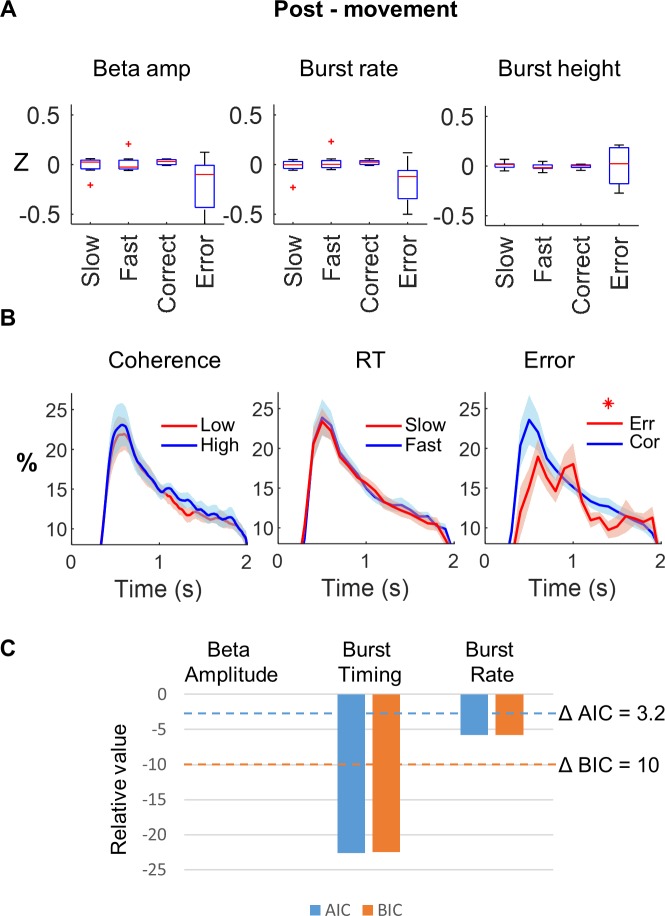
Relationship between beta and errors post-movement.(A) Post-movement beta amplitude, burst rate, and burst height, z-score normalised within subject and split according to trials, with slow versus fast response times and correct versus incorrect trials. Note the decrease in beta amplitude and burst rate on error trials, although this was not significant following FDR correction. (B) Post-movement, there was no significant difference between beta bursts on low and high coherence trials (left panel) or slow versus fast trials (middle panel). Conversely, burst probability (*pFDR < 0.05) was higher for correct (blue) versus error (red) trials across all subjects. The difference at the first peak (600 milliseconds) was nonsignificant following FDR correction, whereas the second peak at 1.4 second remained significant. On the time axis, zero represents the motor response time. Data are down-sampled to 20 Hz. (C) Model comparison of three separate linear mixed effects models incorporating one of single trial beta amplitude (1), beta burst timing (2), and burst rate (3) for response accuracy in the post-movement periods. The burst timing model shows a significantly lower AIC/BIC compared with the beta amplitude model (ΔAIC = −24) and (ΔBIC = −24) for the post-movement period, confirming that burst timing is a better predictor of response accuracy than average single trial beta amplitude. The underlying data can be found at https://osf.io/eu6nx/. AIC, Akaike information criterion; BIC, Bayesian information criterion; FDR, false discovery rate; RT, response time.